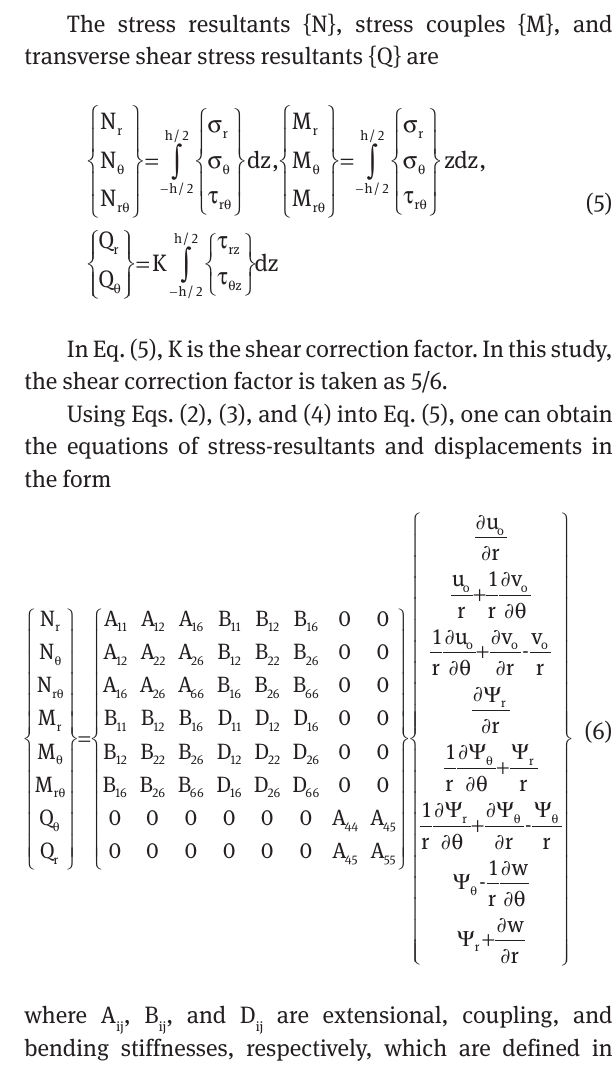
Figure 1 Geometry of a laminated annular circular